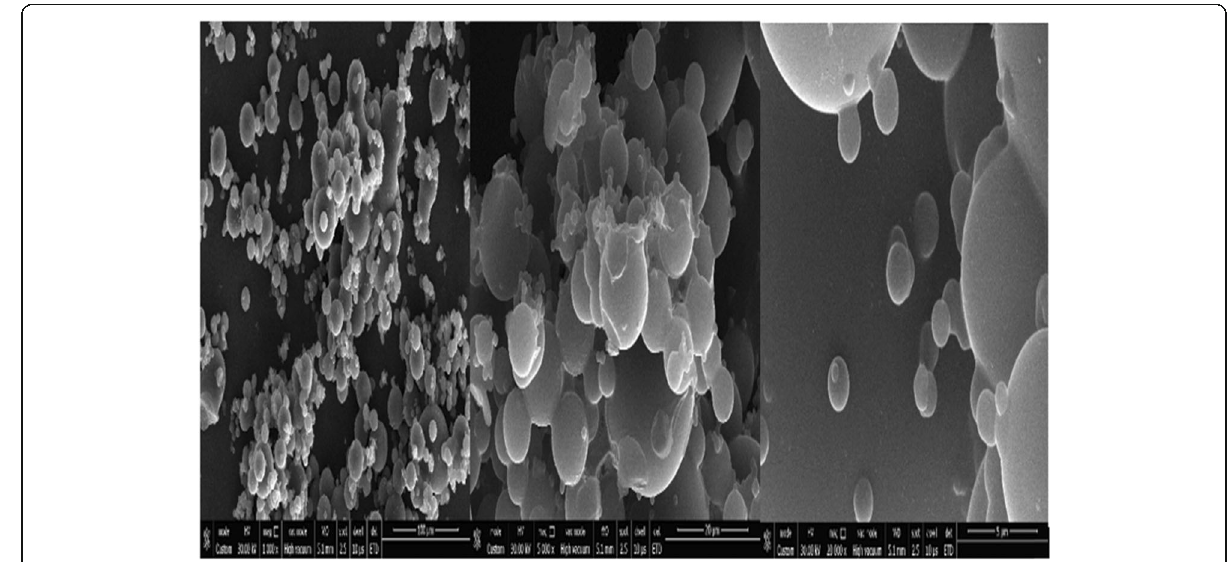
Fig. 1 SEM images of Zinc Nanoparticles ( a ) 1000X Mag. b 5000X Mag ( c ) 20,000X